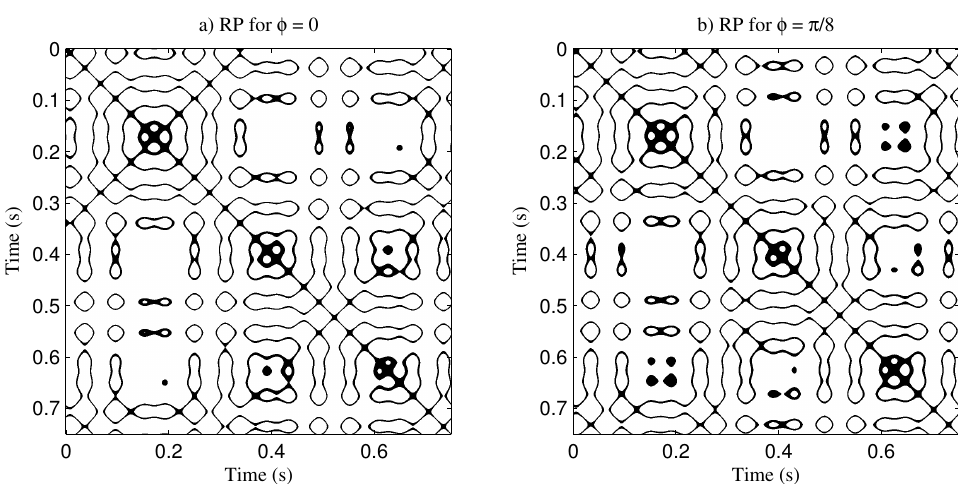
Figure 8. Recurrence plot for the multiple asynchronous function of Equation (12): ( a ) without phase shift ( φ = 0); ( b ) with phase shift ( φ = π /8).